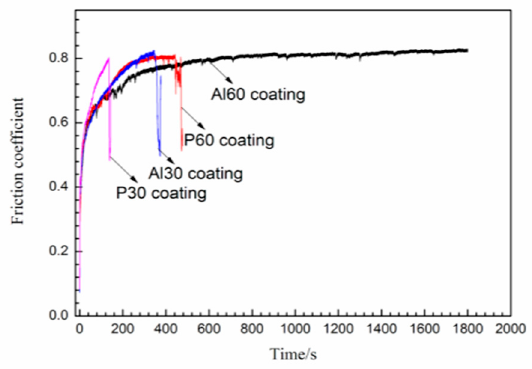
Figure 10. Friction coefficient as a function of sliding time under 7 N for PEO coatings.